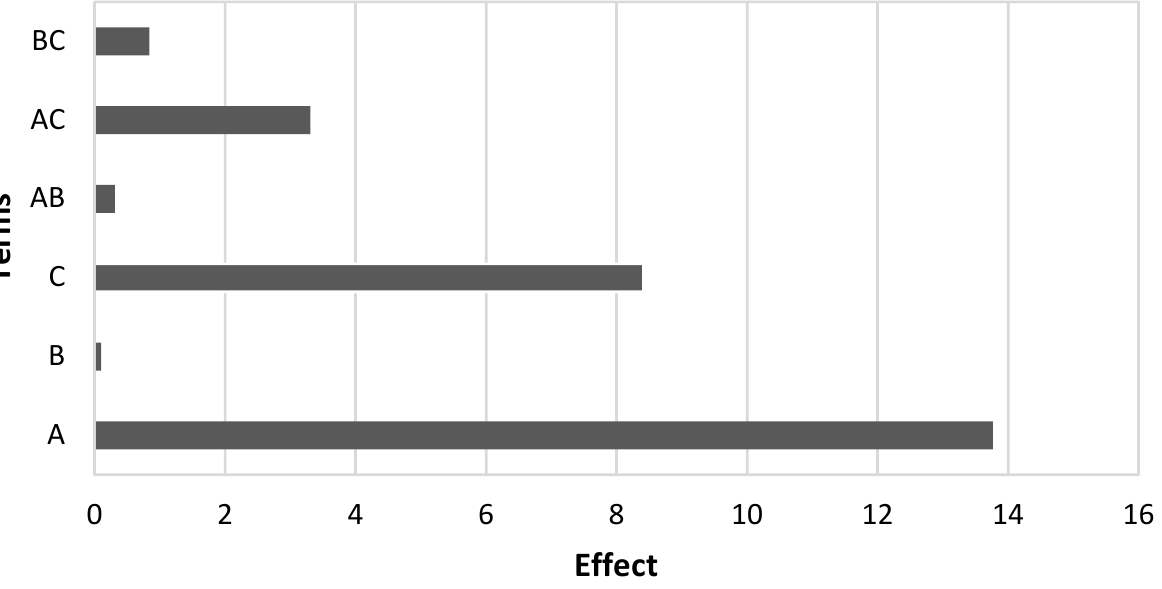
Figure 15. Effects of different test parameters and interactions, computed using Minitab software. Table 4. The p -values for different parameters and